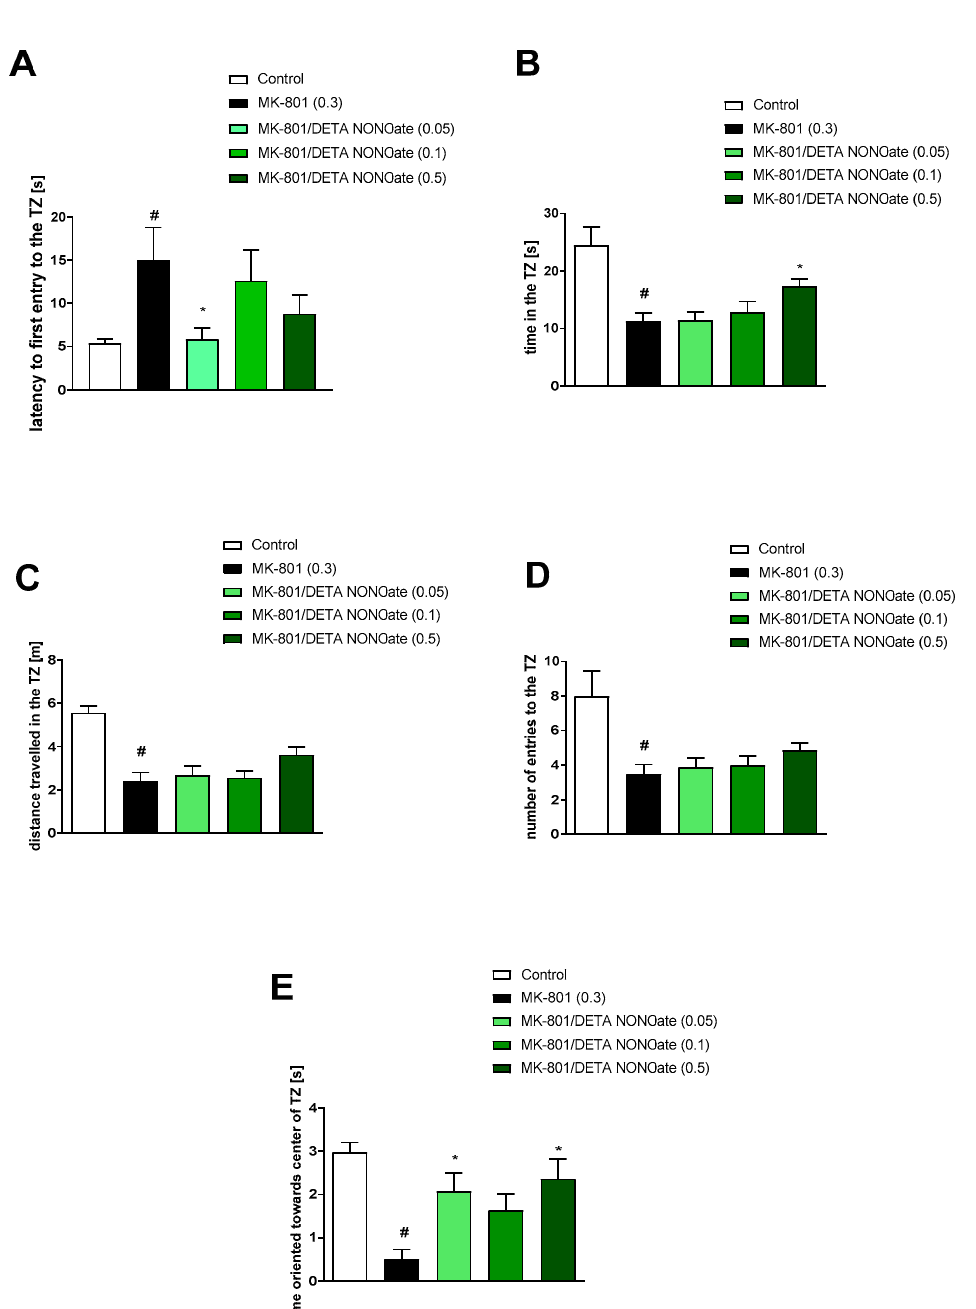
Figure 9. The effects of DETA NONOate on MK-801-induced deficits in the retention of spatial memory in the MWM of CD1 mice. TZ-related parameters. ( A ) the latency to the first entry into the TZ, ( B ) the time in the TZ, ( C ) the distance travelled in the TZ, ( D ) the number of entries into the TZ, and ( E ) the time oriented towards the centre of the TZ when inside the zone. The values are expressed as the means ± SEM. # p < 0.001 vs. control group and * p < 0.05 vs. scopolamine-treated animals (N = 8–10).